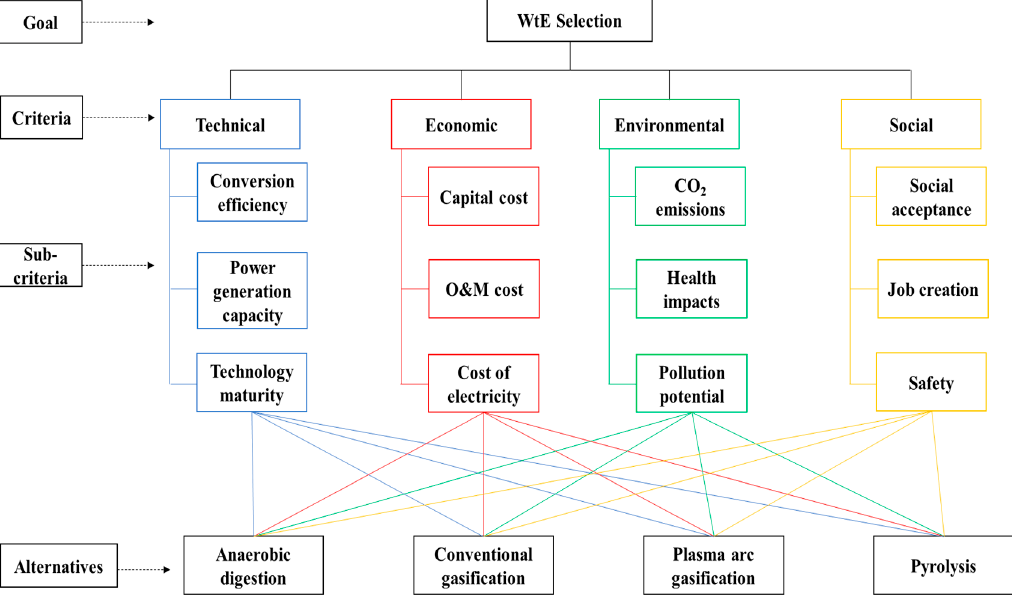
Figure 4. Hierarchical decision tree.